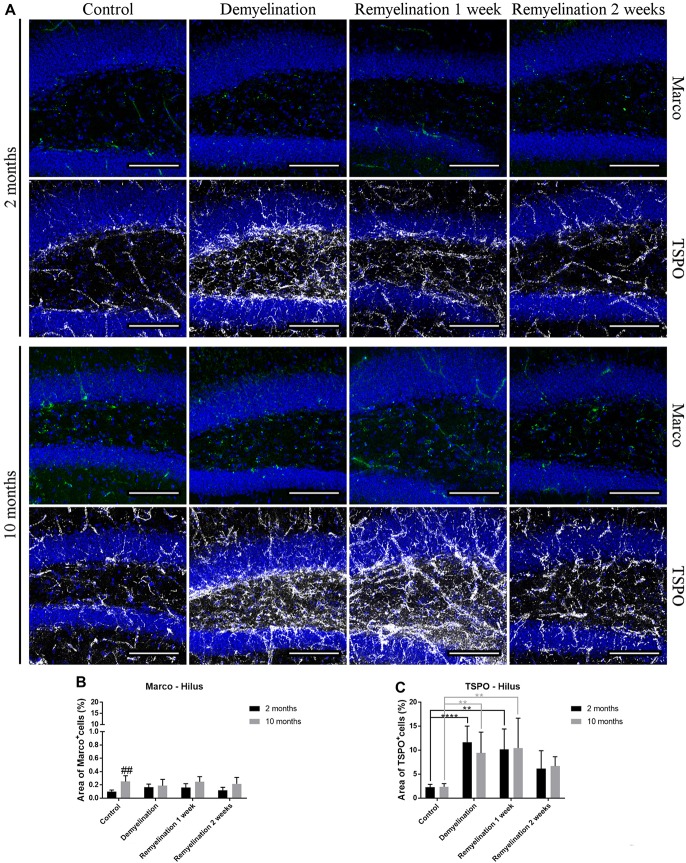
Translocator protein 18 kD (TSPO), but not macrophage receptor with collagenous structure (Marco), reacts to de- and remyelination in the hilus of the hippocampal DG. (A) Marco (green) and TSPO (white) labeling. Cell nuclei are stained with DAPI (blue). (B) Marco staining was significantly higher in the middle-aged control group compared to the young one. De- and remyelination did not significantly change the levels of Marco. (C) TSPO was significantly increased during demyelination and the first week of remyelination in both age groups. Values are shown as means + SD (n = 6 per group). Statistical significance was evaluated using a two-way ANOVA followed by a Tukey’s post hoc test (C). The p-values are indicated in the graphs: treatment effects within the same age group: **p < 0.01 and ****p < 0.0001, age-related differences: ##p < 0.01. Bars: (A) 100 μm.